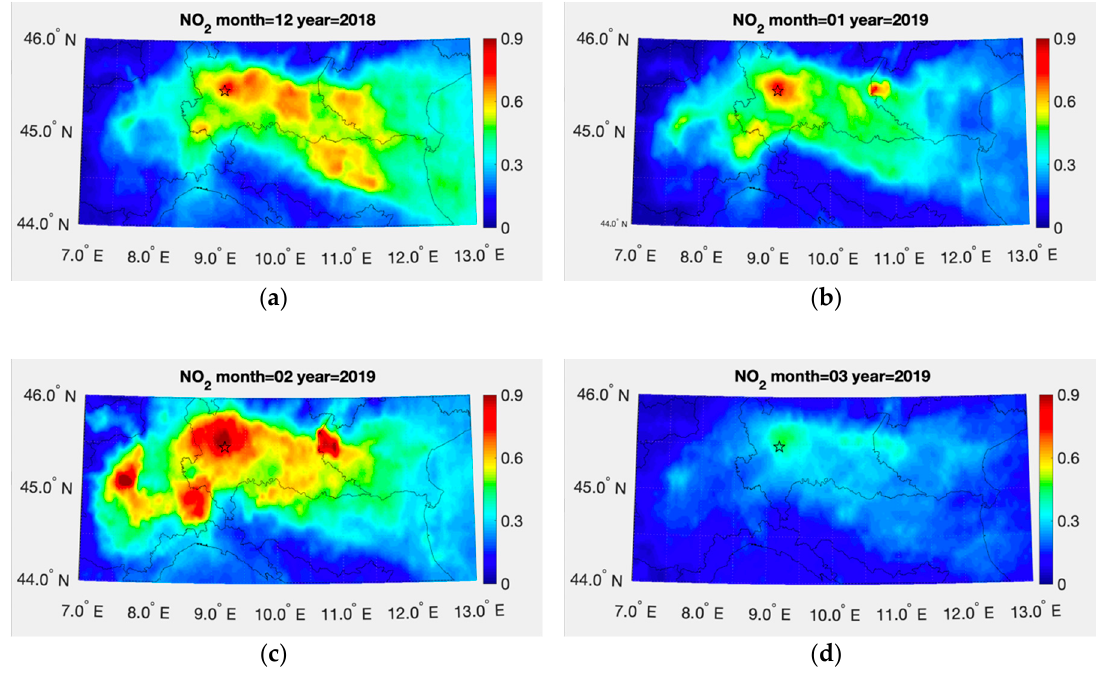
Figure 17. Monthly NO 2 pollution, as revealed by TROPOMI for the period December 2018–March 2019. In particular, December 2018 ( a ) and January ( b ), February ( c ), March ( d ) 2019.